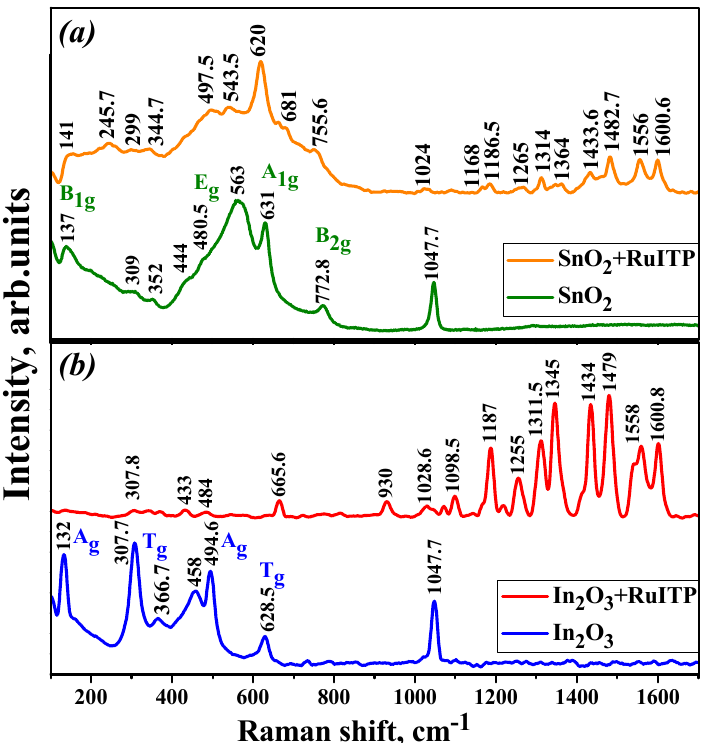
Figure 2. Raman spectra of nanocrystalline SnO 2 ( a ) and In 2 O 3 ( b ) based samples.